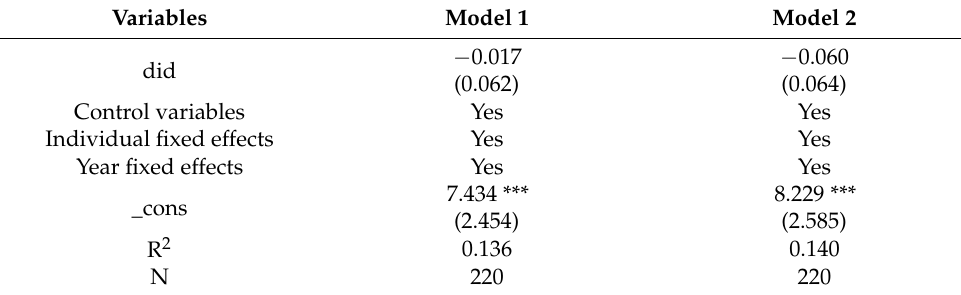
Table 9. Time-placebo test